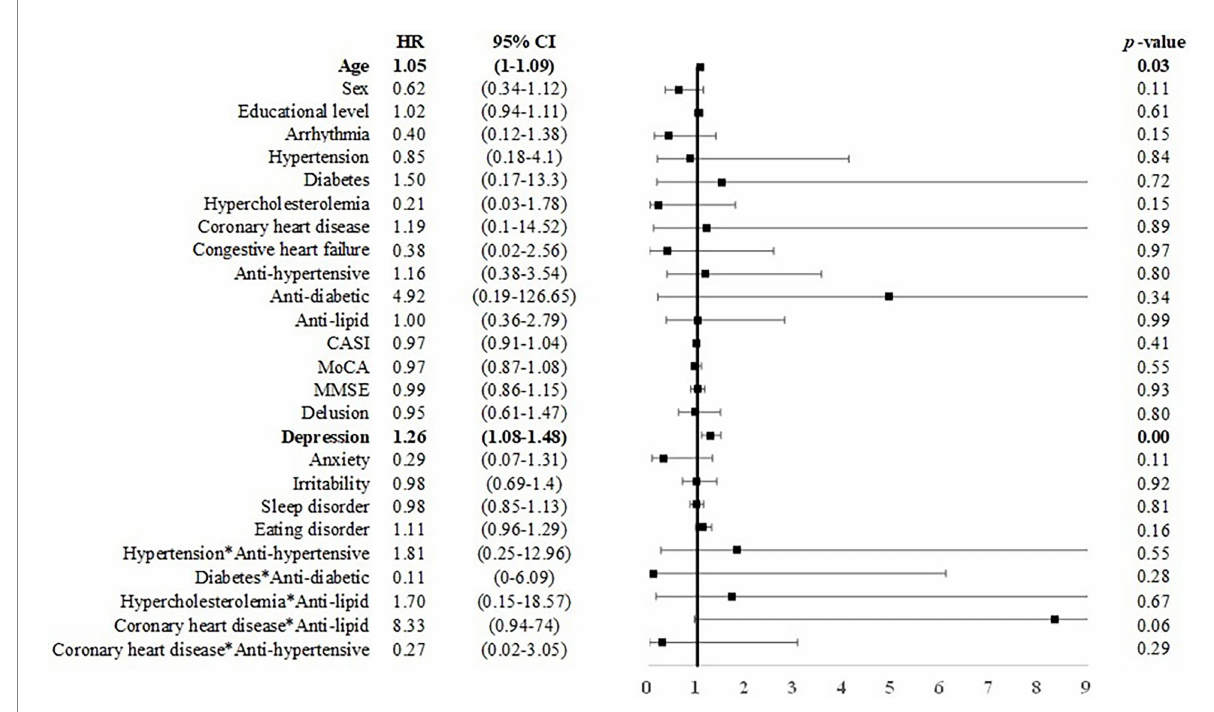
FIGURE 3 Risk of incident dementia among CU individuals. Note and abbreviations as those used in Figure 2.